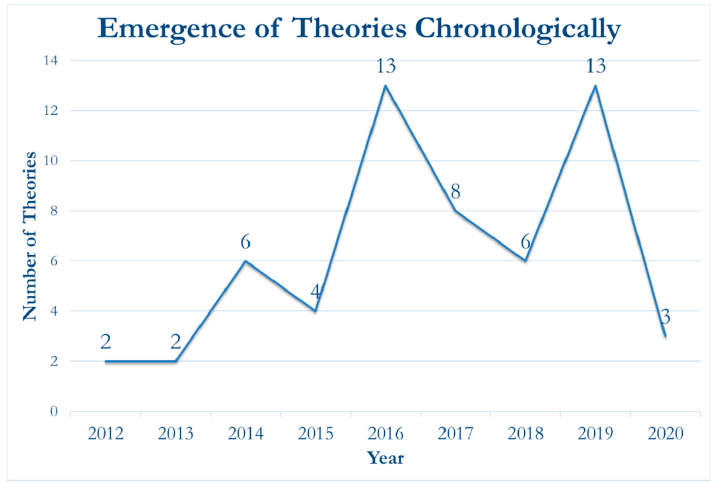
Figure 2. Employed Theories Year-wise.